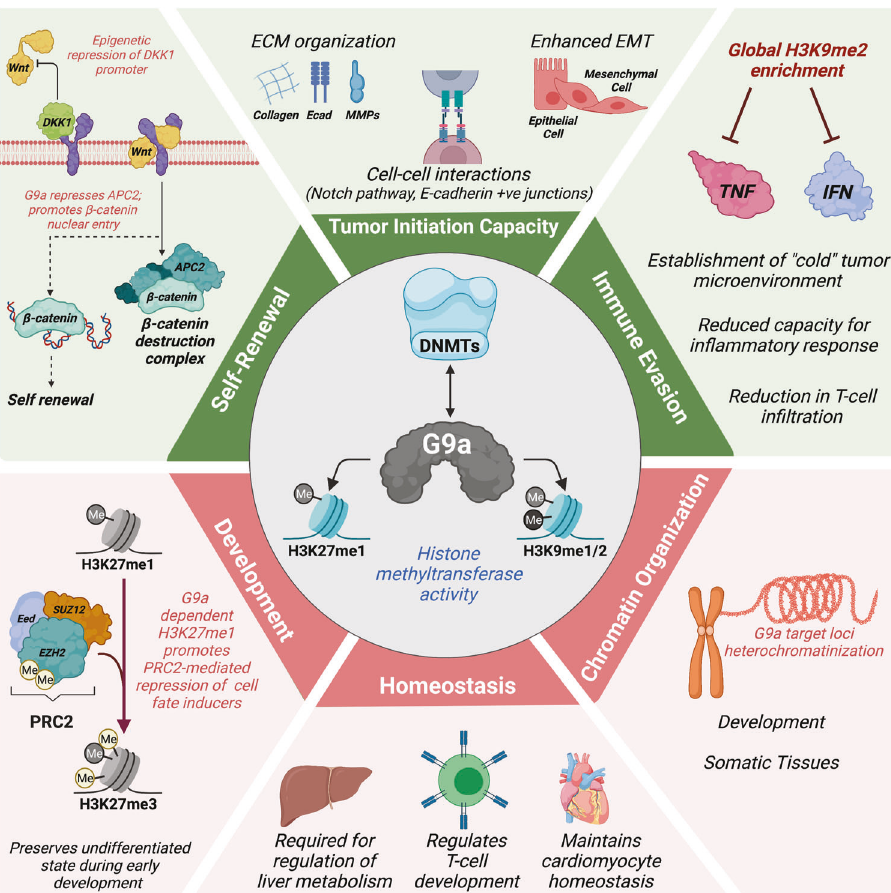
Fig. 2 Context-speci fi c roles of G9a in neoplastic and healthy tissues. In cancer stem cell populations (green), G9a functions at multiple levels to drive cancer progression through molecular networks maintaining self-renewal and tumorigenicity. By promoting the CSC phenotype, G9a contributes to tumor immune evasion. On the other hand, in healthy tissues (red), G9a is an essential regulator of cell fate and differentiation genes, homeostasis, and maintenance of heterochromatin. Although G9a was extensively linked to cancer progression, the untargeted inhibition of its HMTase activity may have deleterious effects on normal cell functions and compromise future translational